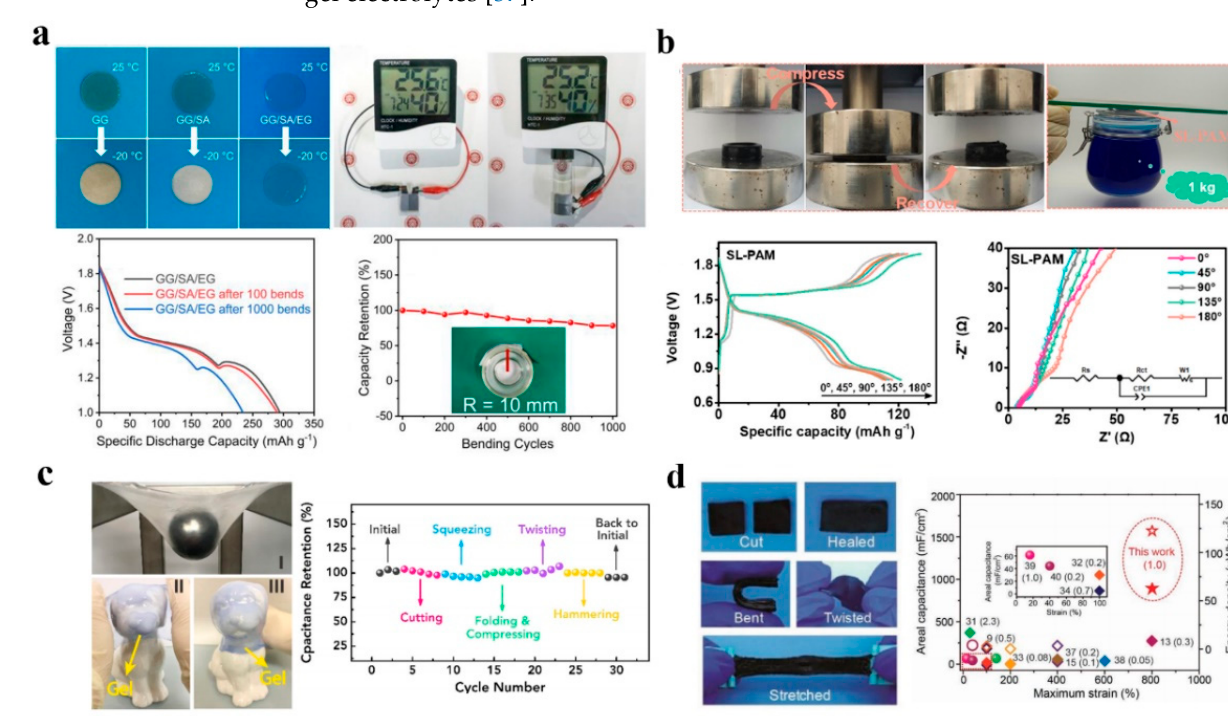
Figure 3. ( a ) Optical image of hydrogel electrolytes at 25 °C and − 20 °C and electrochemical performance of full flexible battery. Reproduced with the permission of ref. [37], copyright 2021 Elsevier B.V. ( b ) PAM and SL − PAM hydrogels in zinc ion batteries: compressibility and stress − strain curves. Reproduced with the permission of ref. [38], copyright 2021 Elsevier Inc. ( c ) Analyses of the mechanical (I, II and III ) and electrochemical properties of the Al-alginate/PAAm hydrogels. Re- produced with the permission of ref. [39], copyright 2019 Elsevier Ltd. ( d ) Electrochemical and cut − heal test under different conditions including bending, twisting and stretching at high strains. Reproduced with the permission of ref. [40], copyright 2019 WILEY − VCH.